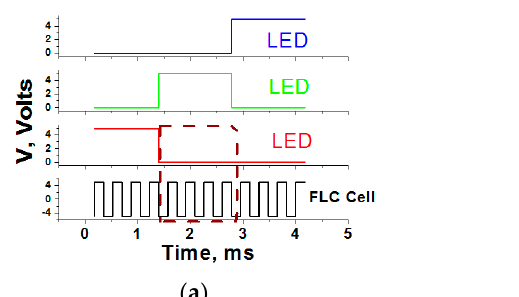
RGB LEDs. The fourth waveform is the driving signal of ESH cell. ( b ) Some of the achieved colors with